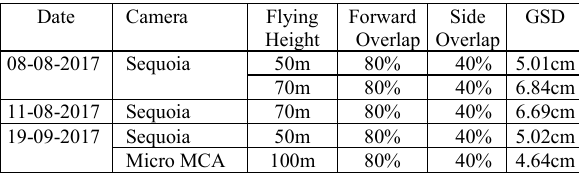
Table 3. Image acquisition details and image